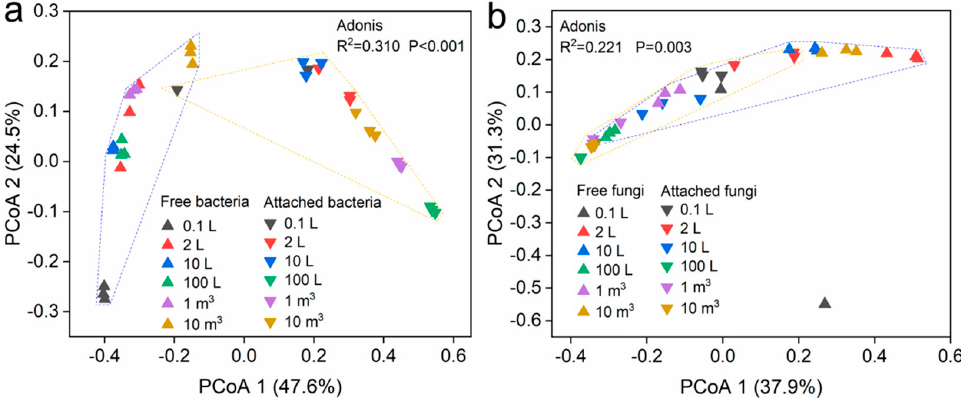
Figure 3. PCoA ordination of the dissimilarity between the free and attached microbial communities based on Bray–Curtis distance: ( a ) bacteria; ( b ) fungi. Adonis: nonparametric multivariate analysis of variance.